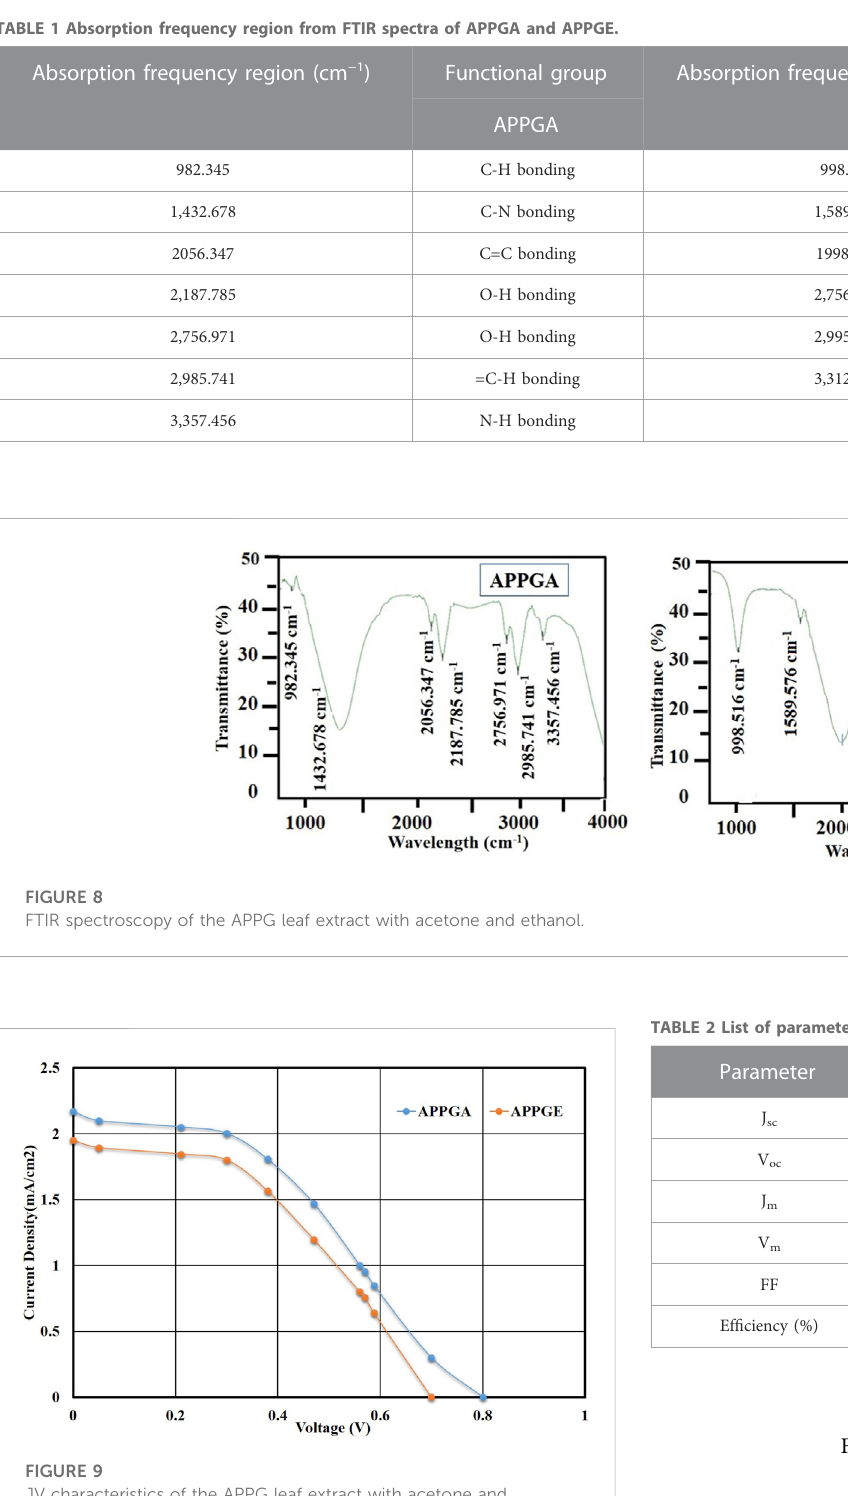
JV characteristics of the APPG leaf extract with acetone and ethanol.